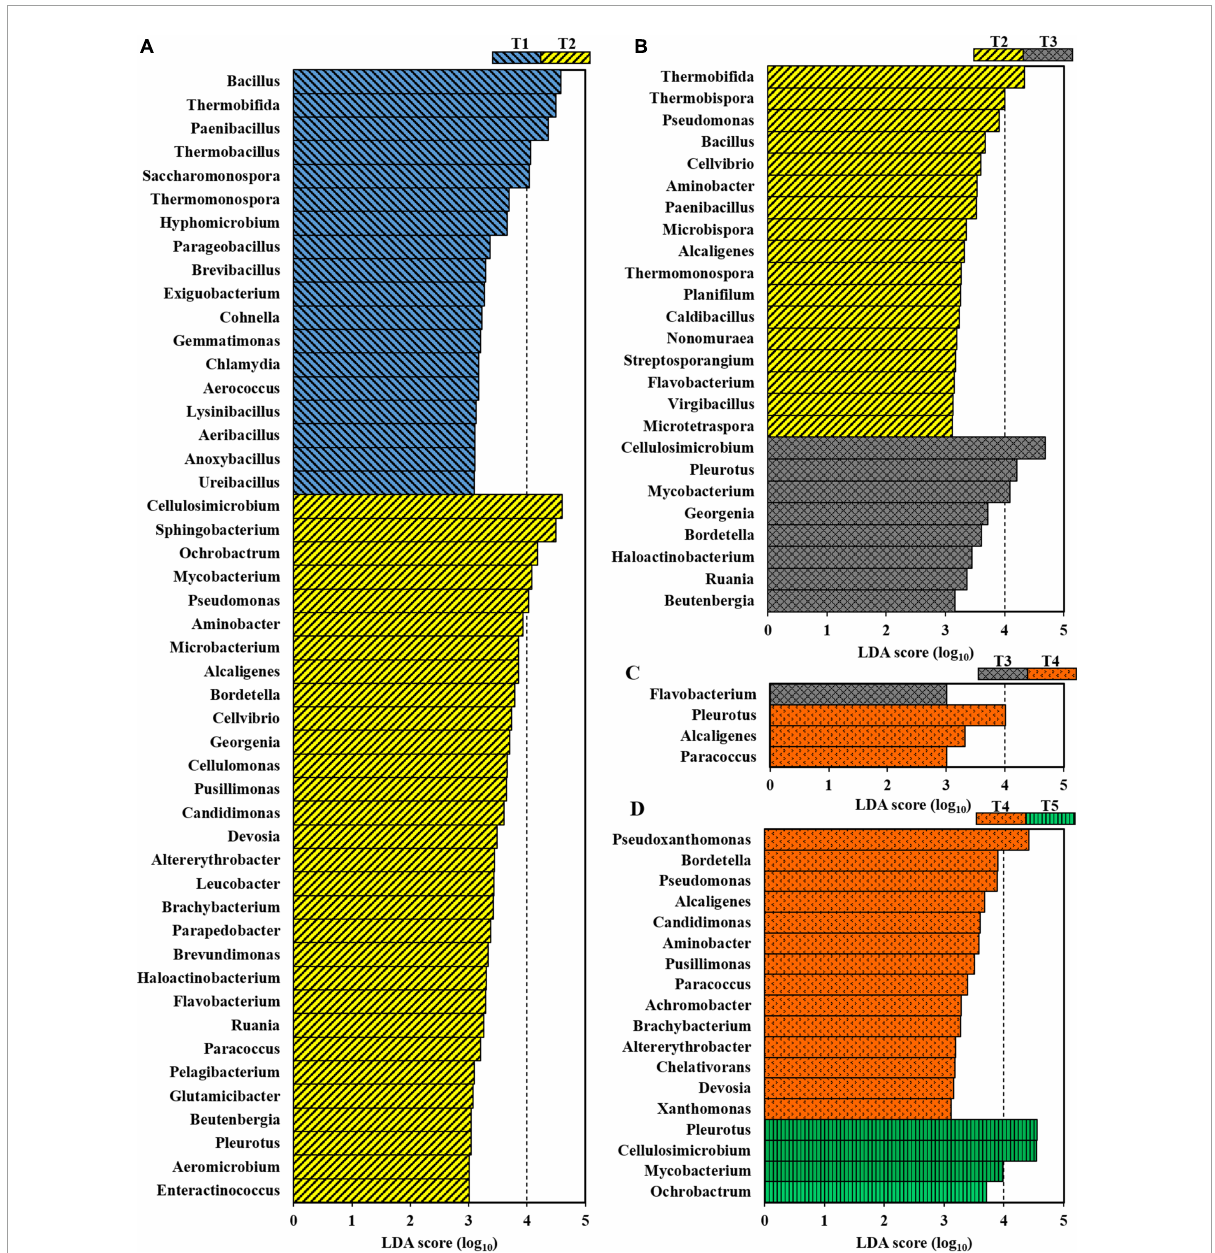
FIGURE4 Taxonomic differences at the genus level for bacteria in composting substrate at the different growth stages of oyster mushroom using a linear discriminant analysis (LDA) and effect size (LEfSe) method (LDA threshold = 3.0). (A) T1 vs. T2; (B) T2 vs. T3; (C) T3 vs. T4; and (D) T4 vs. T5. T1, T2, T3, T4, and T5 indicate the day on which composting was completed (day 0: before spawning), mycelial colonization (day 3), mid-incubation (day 10), end-incubation (day 20: before primordia formation), and first oyster mushroom fructification (day 30: fruiting body development),